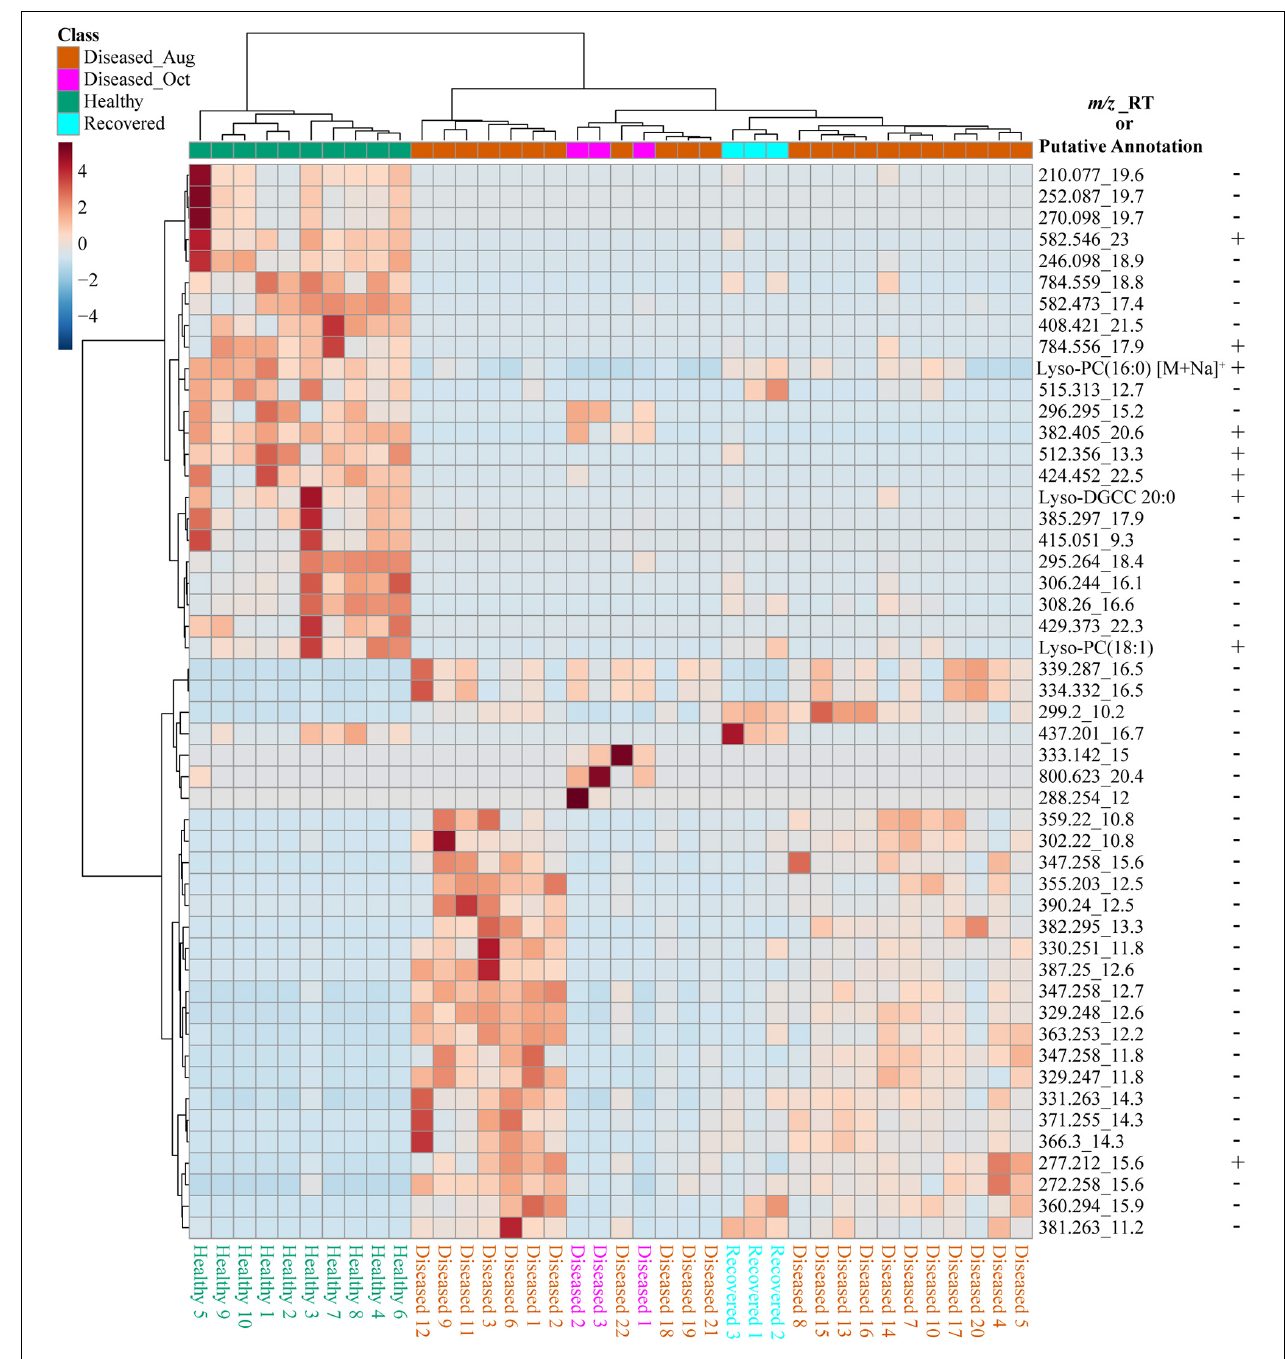
FIGURE 7 | The heat map of the top 50 significant features driving the separation of healthy, diseased, and recovered coral samples identified via analysis of variance from LC-MS data using MetaboAnalyst. The scale bar represents autoscaled intensity of features. The putative annotations of these features are provided in Supplementary Table 1 . The m/z _RT column lists the m/z value and retention time in minutes of each feature, as well as a few putative annotations. The ± indicates presence or absence of this feature in the LC-MS data acquired on cultured